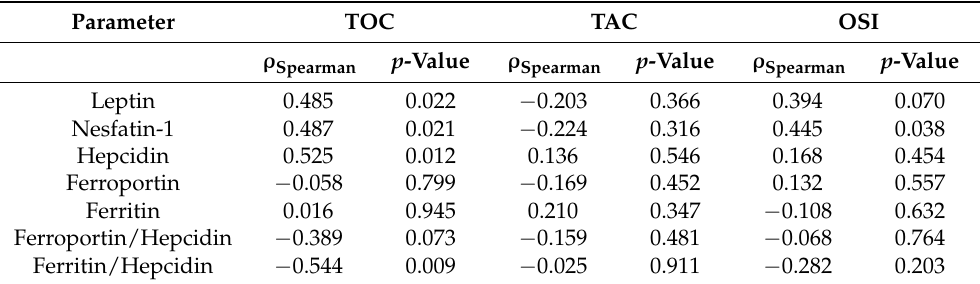
Table 3. Associations between total oxidant and antioxidant capacity, OSI and serum adipokines, and acute phase protein concentrations in patients with PWS.